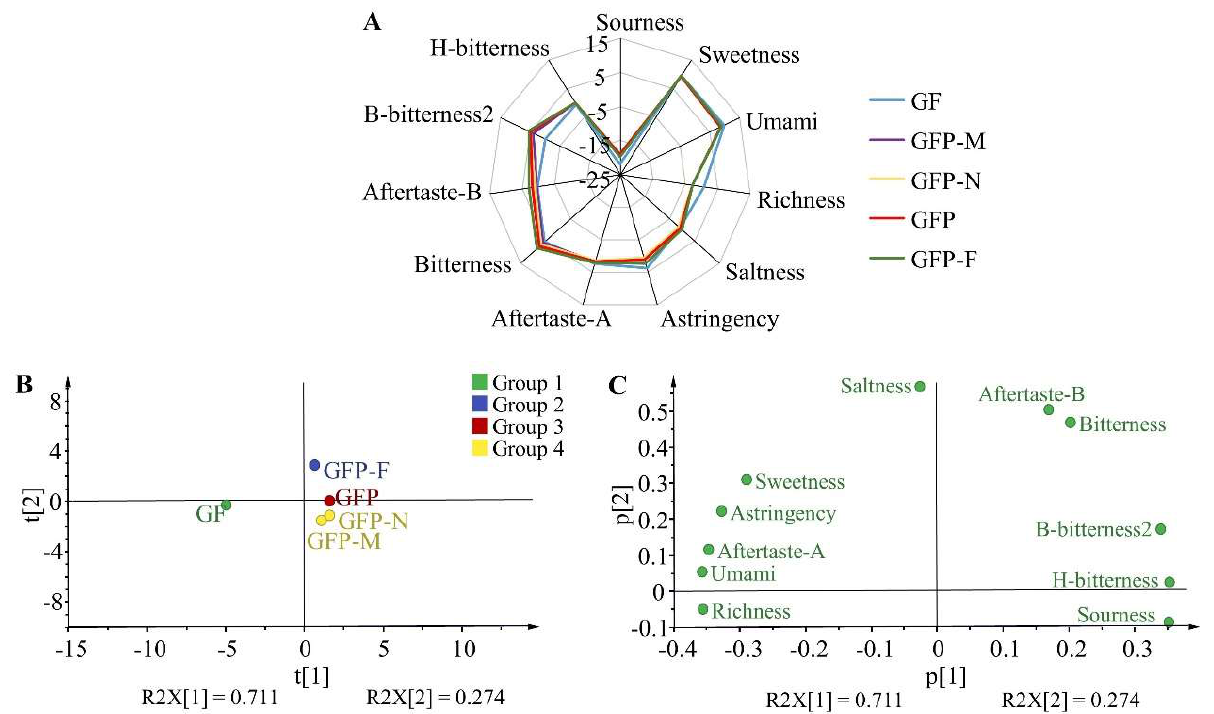
Figure 5. The taste information of five GFP processed decoction pieces. ( A ) Radar map of response value. ( B ) PCA analysis of electronic tongue data. ( C ) Loadings analysis of electronic tongue data.